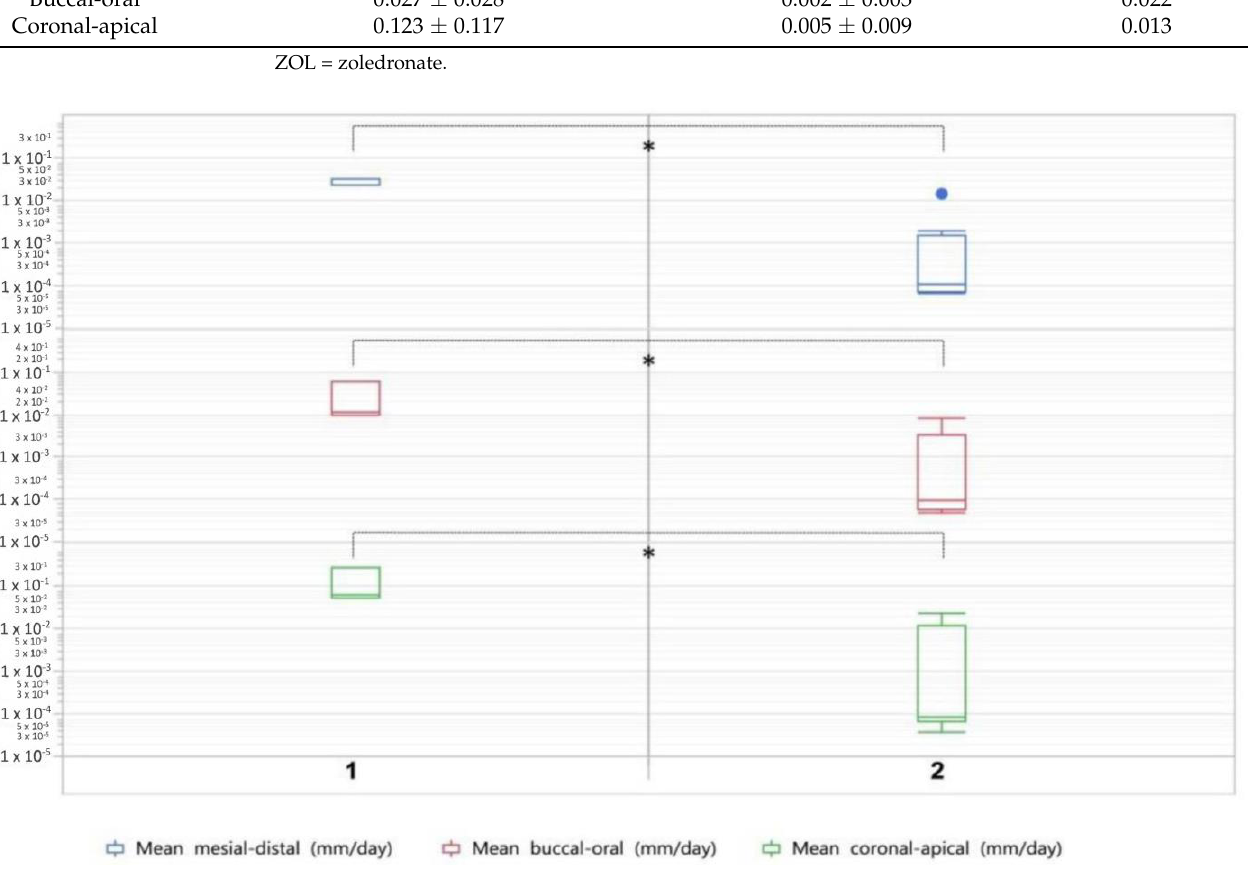
Figure 2. Box plots showing tooth growth in minipigs not administered ZOL ( 1 ) and minipigs ad- ministered ZOL ( 2 ). Asterisk indicates statistically significant differences ( p ≤